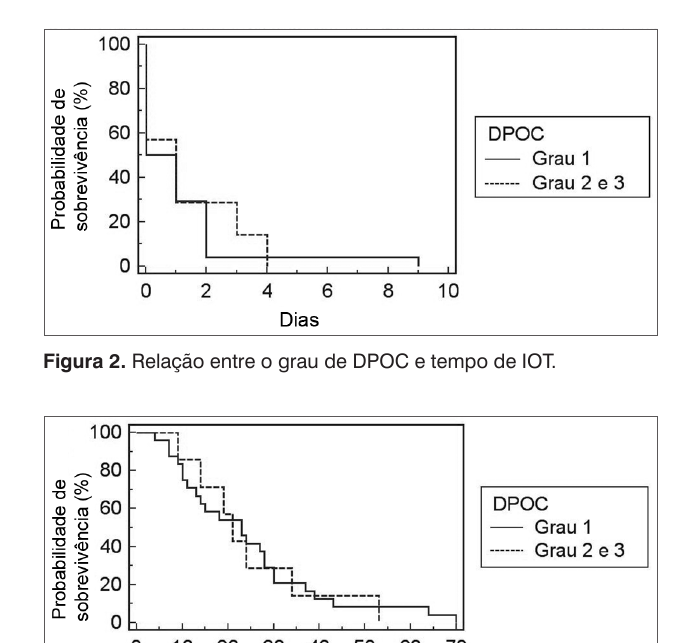
Figura 1. Relação entre o grau de DPOC e tempo em UTI.